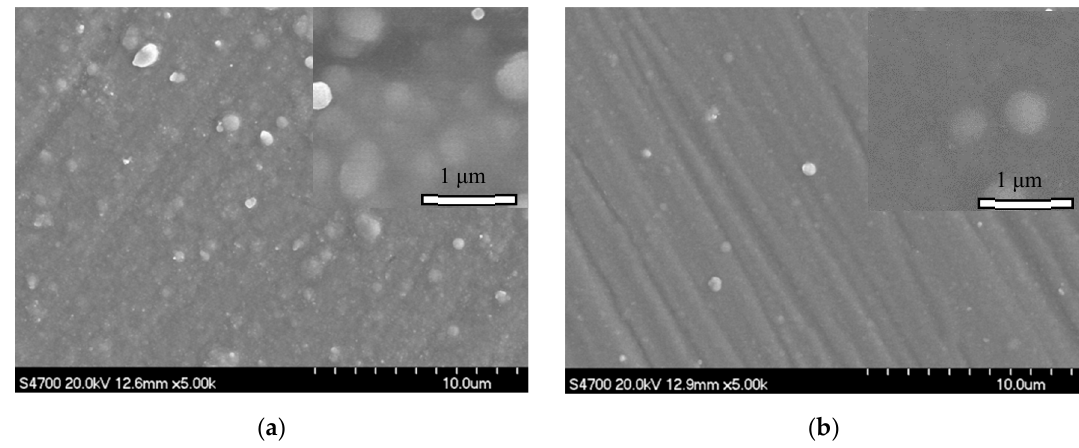
Figure 5. The surface morphology of the Pd-Ni alloy films that were plated in a solution containing different contents of CeCl 3 : ( a ) 0 g L − 1 CeCl 3 and ( b ) 1 g L − 1 CeCl 3 .